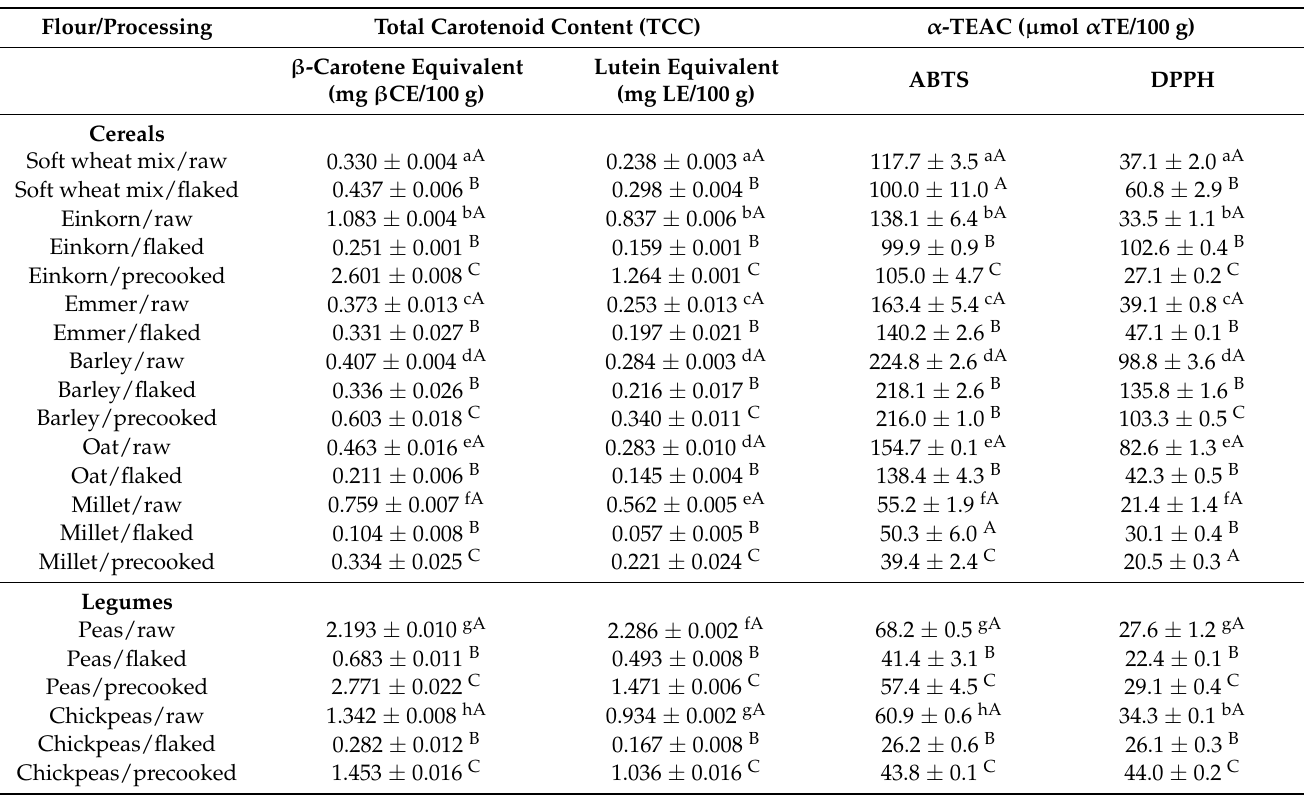
Table 6. Total carotenoid contents (TCC) and α -TEAC/ABTS and α -TEAC/DPPH value assays in the lipophilic extracts, reported as mean ± SD ( n =